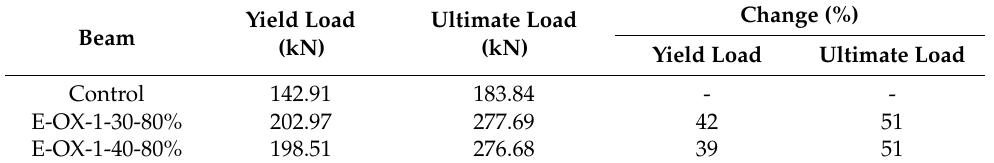
Table 4. Experimental results of NSM-strengthened RC beam (Concrete strength).